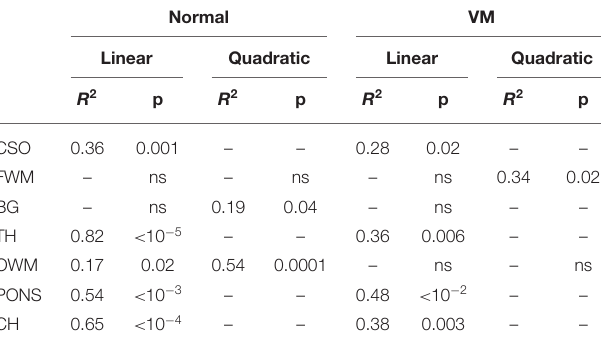
TABLE 2 | Regression analysis between ADC and gestational